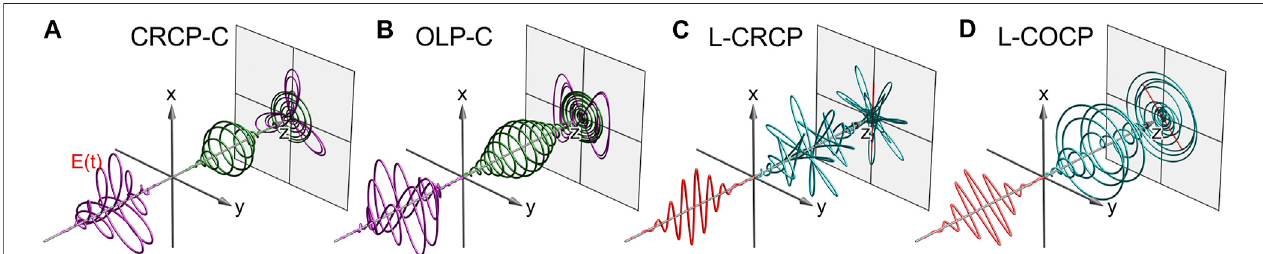
FIGURE12| Trichromatic pulse sequences. The projection in z -direction visualizes thetime-dependent electric fi eld vector at theposition oftheatom ormolecule. (A) Circularly polarized single pulse followed by a CRCP pulse sequence, (B) Circularly polarized single pulse followed by an OLP pulse sequence, (C) CRCP pulse sequence followed by a linearly polarized ( s ) single pulse and (D) COCP pulse sequence followed by a linearly polarized single pulse tilted by 45 ° . In all fi gures the single pulse is separated by a delay τ > 2 Δ t from the coinciding pulse